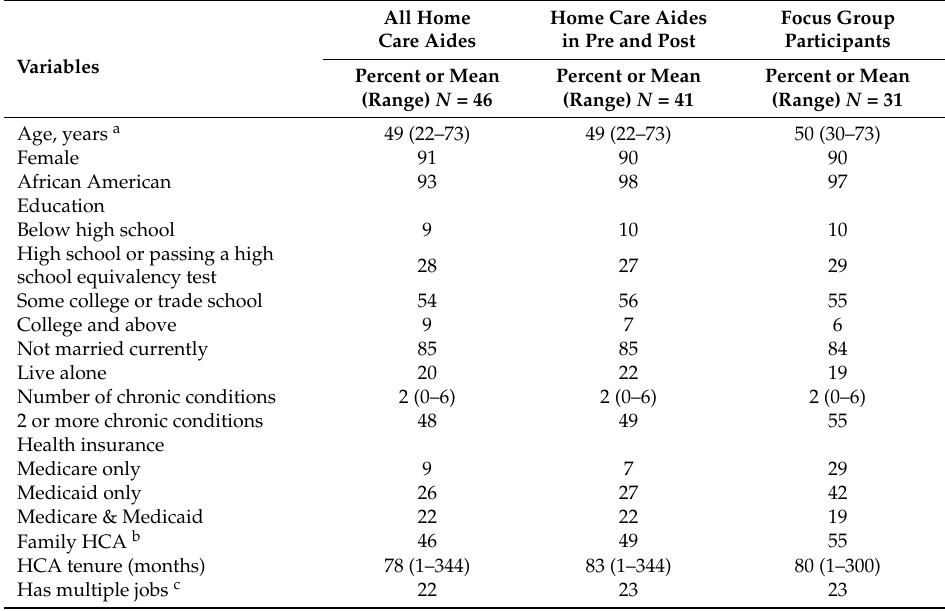
Table 1. Baseline characteristics of home care aides.